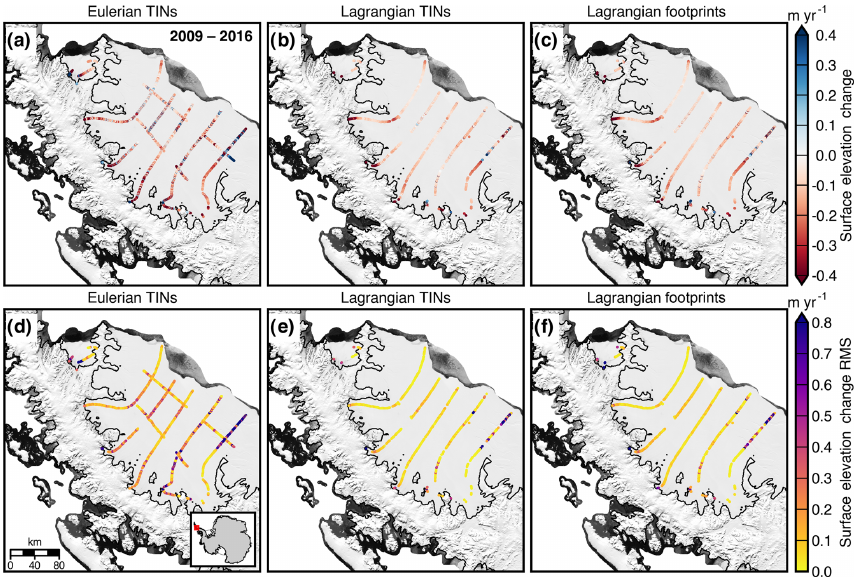
Figure 4. Surface elevation change of the Larsen-B remnant and Larsen-C Ice Shelf derived using (a) Eulerian TINs corrected for strain, (b) Lagrangian TINs, and (c) Lagrangian overlapping footprint schemes for the period 2009–2016. The rms differences in elevation change from a measurement point for all points within 1km for the (d) Eulerian TINs corrected for strain, (e) Lagrangian TINs, and (f) Lagrangian overlapping footprint methods. The elevation change rates shown here are not RDE filtered (Smith et al., 2017). Antarctic grounded ice boundaries are provided by Mouginot et al. (2017b). Plots are overlaid on a 2008–2009 MODIS mosaic of Antarctica (Haran et al., 2014). The inset map denotes the location of the